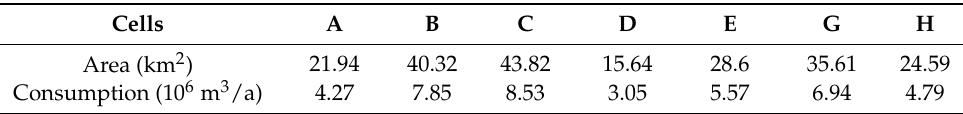
Table 2. Water consumption of each cell.